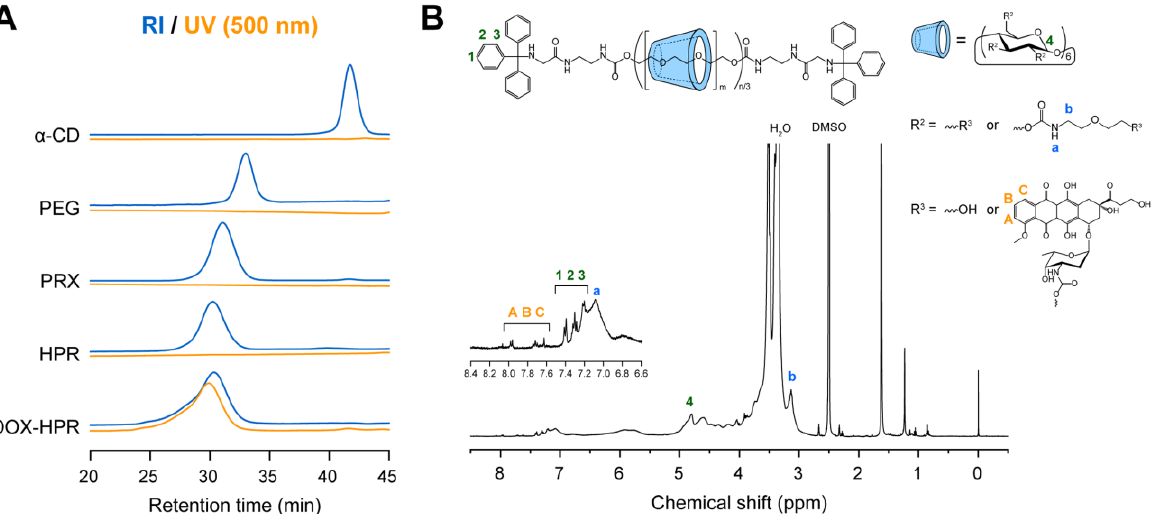
Figure 3. ( A ) SEC charts of α-CD, axle PEG, PRX, HPR, and DOX-HPR in dimethyl sulfoxide (DMSO) monitored with refractive index (RI) and UV (500 nm) detectors. ( B ) 1 H NMR spectrum of DOX-PRX in DMSO- d 6 .